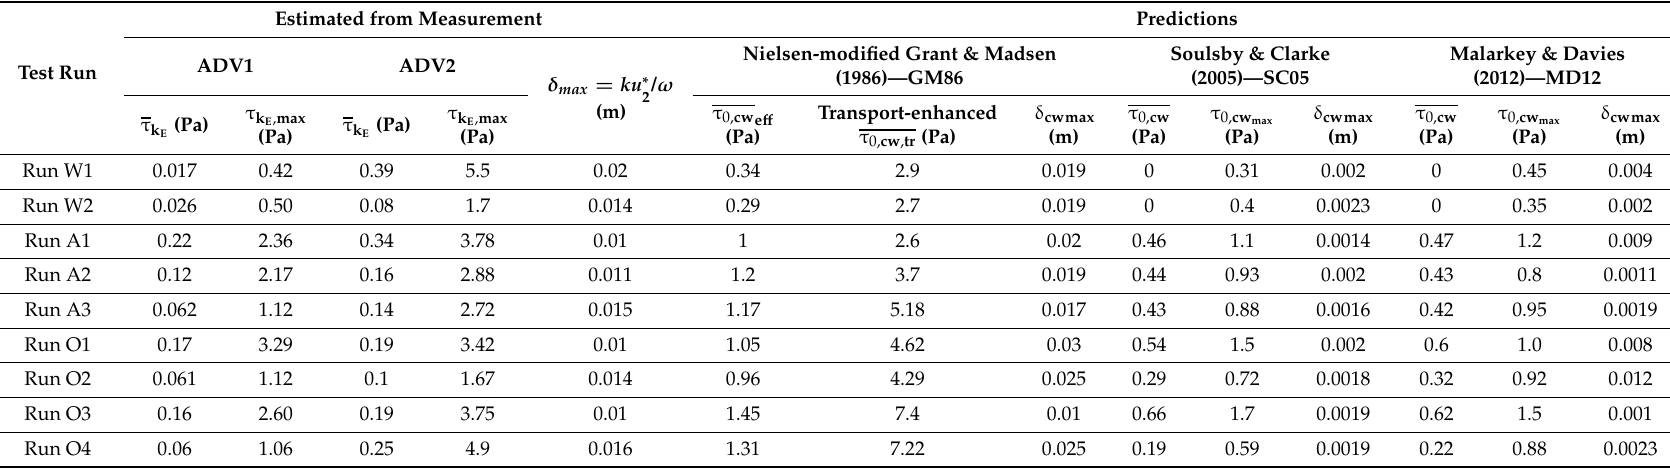
Table 3. Estimated and predicted mean and maximum shear stresses, and corresponding maximum oscillating ( / combined wave-current) boundary layer thickness, δ cw , max derived from shear velocities inferred through the turbulent kinetic energy method for ADV1 and ADV2; and the models of GM86 (e ff ective: τ 0,cwe ff , and transport-enhanced, τ 0,cw,tr ), SC05, and